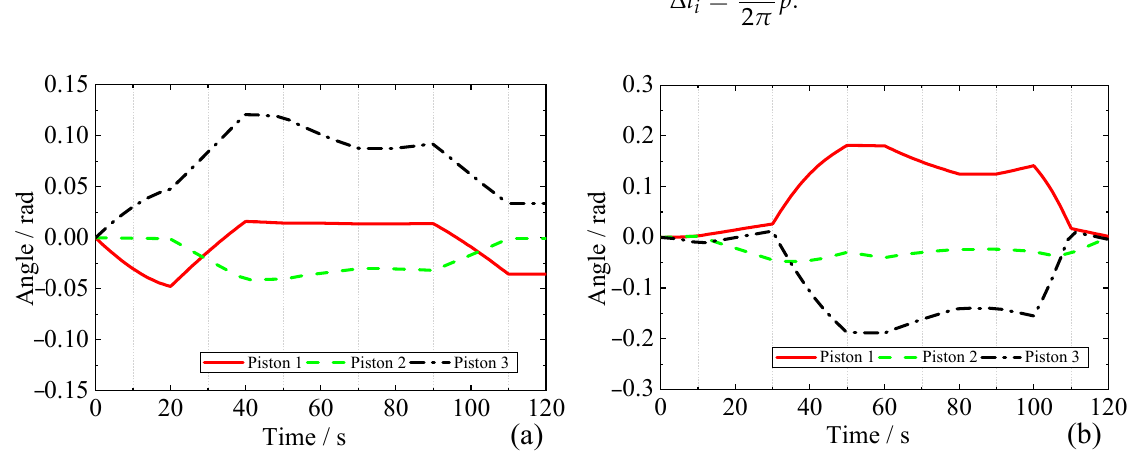
of the HKM to improve the operation accuracy. Figure 9. Rotation angle of HKM spherical joint around the link during the left outboard ( a ) and inboard ( b ) BB lifting.